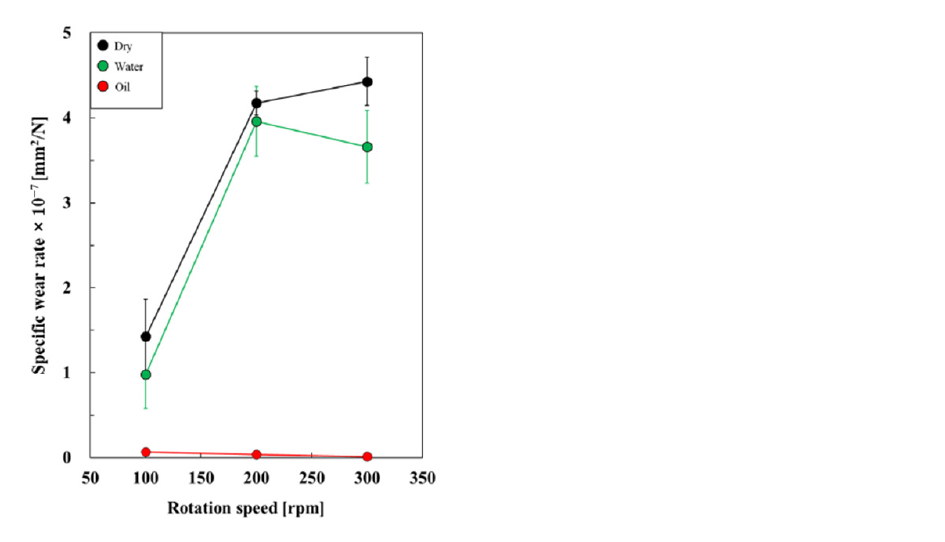
Figure 3. W s of AISI304 blocks against HSS disk obtained from wear tests under dry, water-, and oil- lubricated conditions.